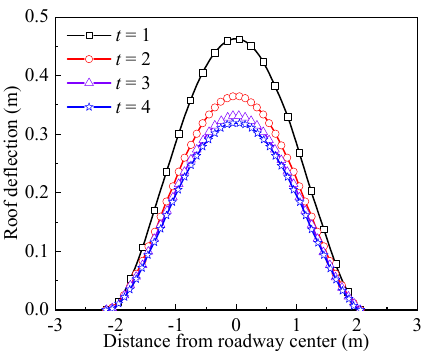
Figure 11. Relationship between composite roof deflection and shape parameter. It can be seen from Figure 11 that when the shape parameter t = 1, the maximum deflection of mudstone stratification is 0.464 m. When the shape parameter t increases to 2, the maximum deflection of mudstone stratification decreases sharply to 0.365 m.